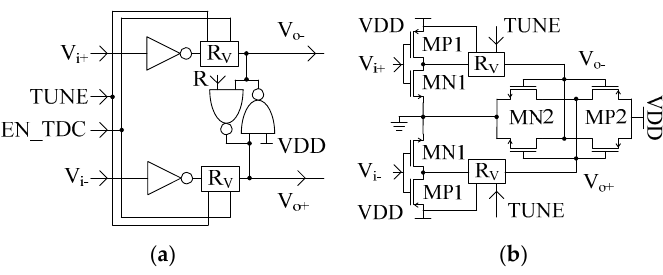
Figure 3. Delay cell ( a ) Block diagram ( b ) Equivalent schematic when signals R and EN_TDC are connected to the voltage supply VDD.